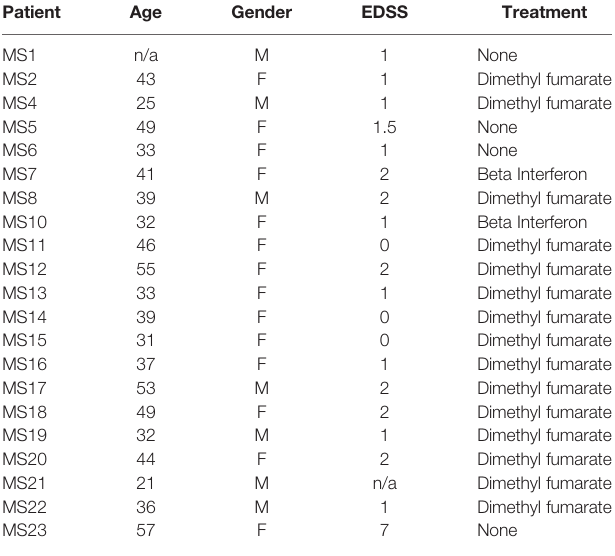
TABLE 1 | Multiple Sclerosis (MS) patient